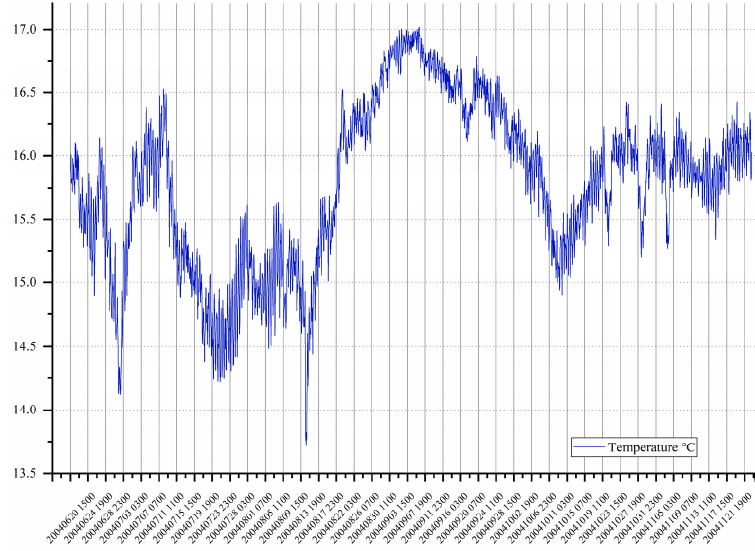
Figure 7. Temperature data at 400 m underwater of KEO station.